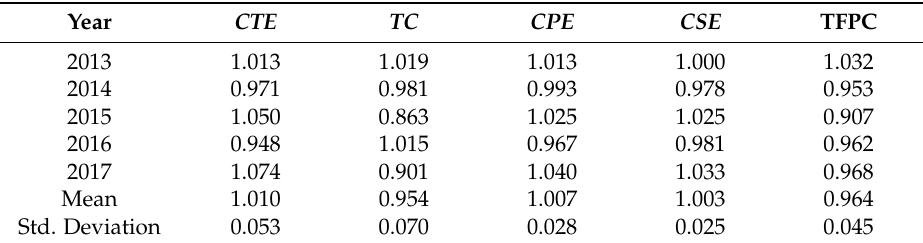
Table 4. The average Malmquist total factor productivity of banking